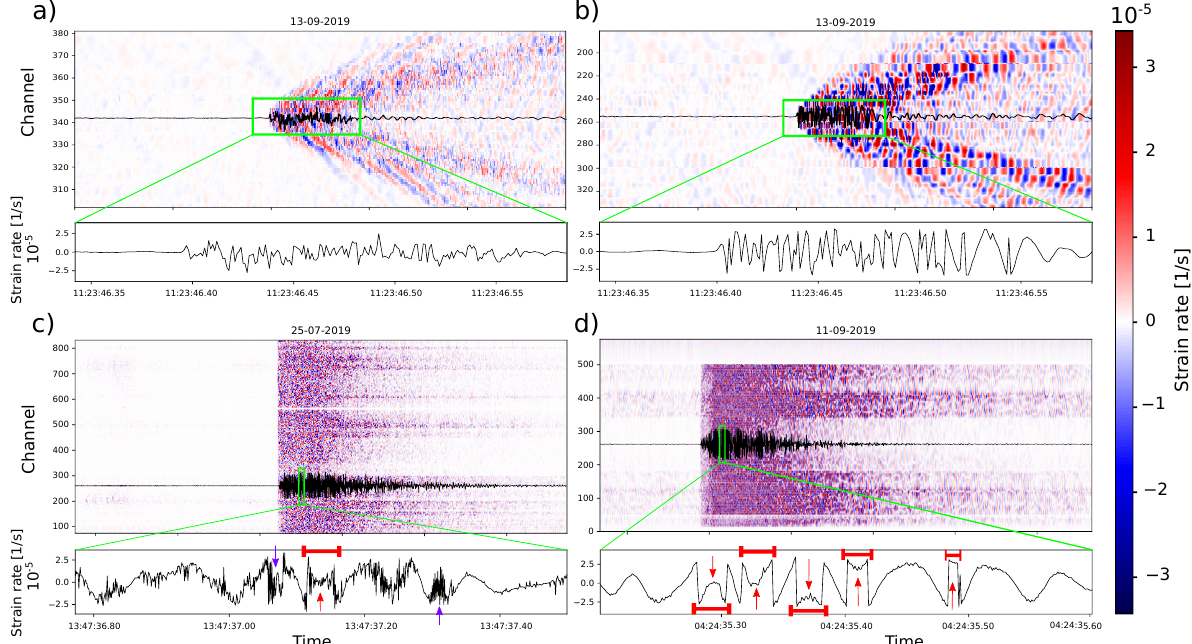
Figure 4. Example of DDSS signals for specific channels in: ( a ) standard fiber for a tap test signal, ( b ) engineered fiber for a tap test signal, ( c ) standard fiber for a local earthquake signal, and ( d ) engineered fiber for a local earthquake signal. In each subfigure, the top part shows the DDSS data across channels, with the waveform of one selected channel, and on the bottom, a zoomed version of the same signal, indicated by the green square. For standard and engineered DDSS data, the tap test signal is the same (10 Hz) and is shown in one part of the common section. However, the local earthquake is not (6 and 10 Hz for ( c , d ), respectively). Subfigures ( c , d ) show indications of recognized major phase jumps (red arrows) and minor phase jumps